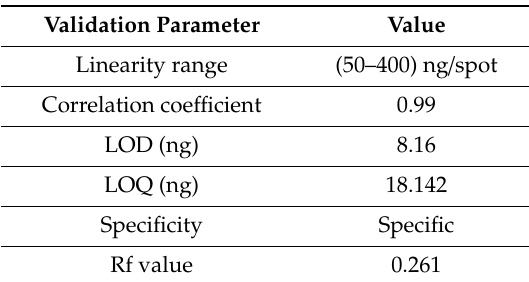
Table 3. Validation parameters for High-Performance Liquid Chromatography (HPLC). LOD: limit of detection; LOQ: limit of quantitation. Rf, Retention factor.